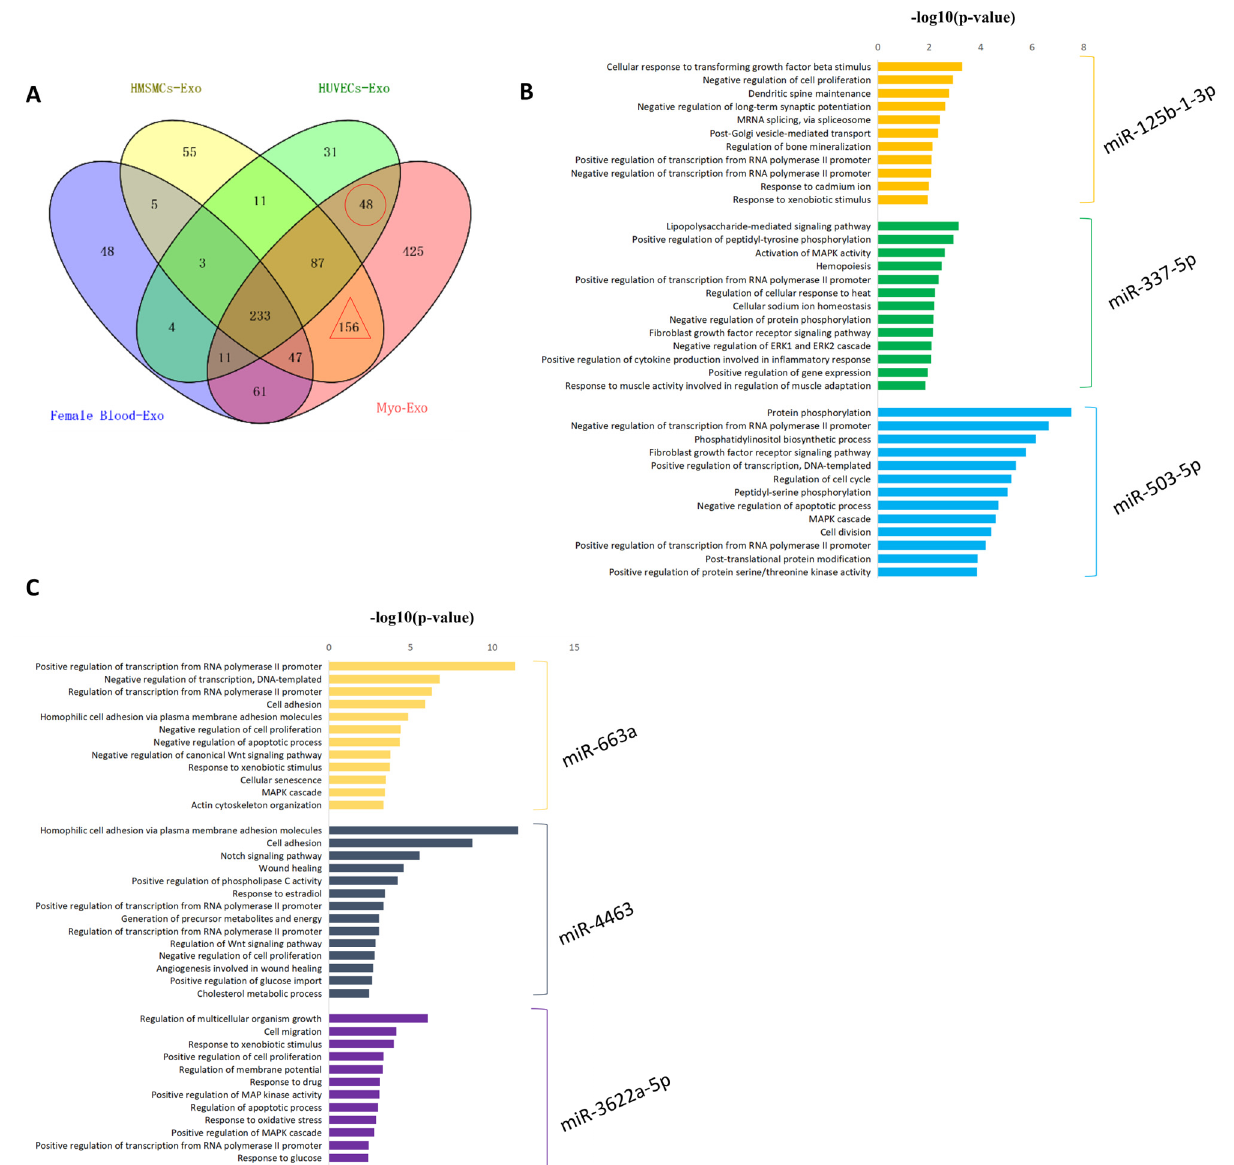
Figure 3. Cell-specific secreted miRNAs in tissue exosomes. ( A ) Venn diagram of the proteins identified in HMSMC, HUVEC, and female blood- and male blood-Exo. ( B ) Top 3 miRNAs with the highest expression levels in HMSMCs-specific miRNAs. ( C ) Top 3 miRNAs with the highest expression levels in HUVECs-specific miRNAs.